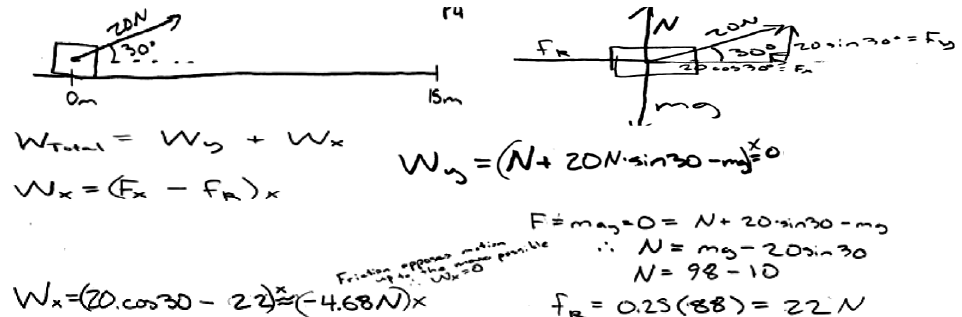
FIG. 13. Inclusion of diagrams which were used in conjunction with